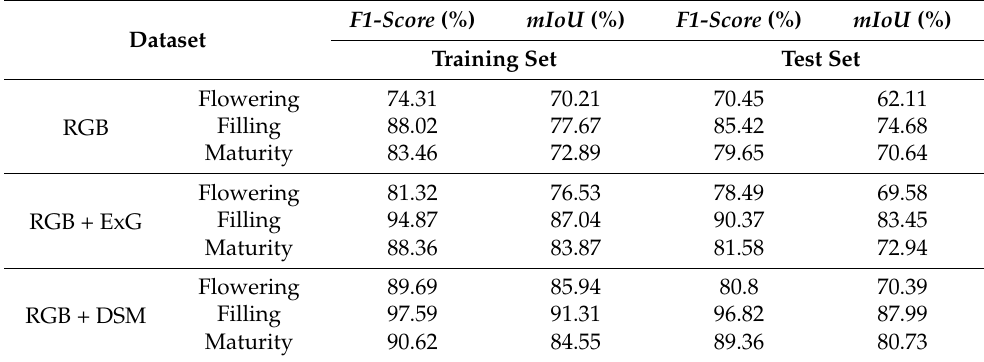
Table 2. Segmentation results using different data of three different periods.